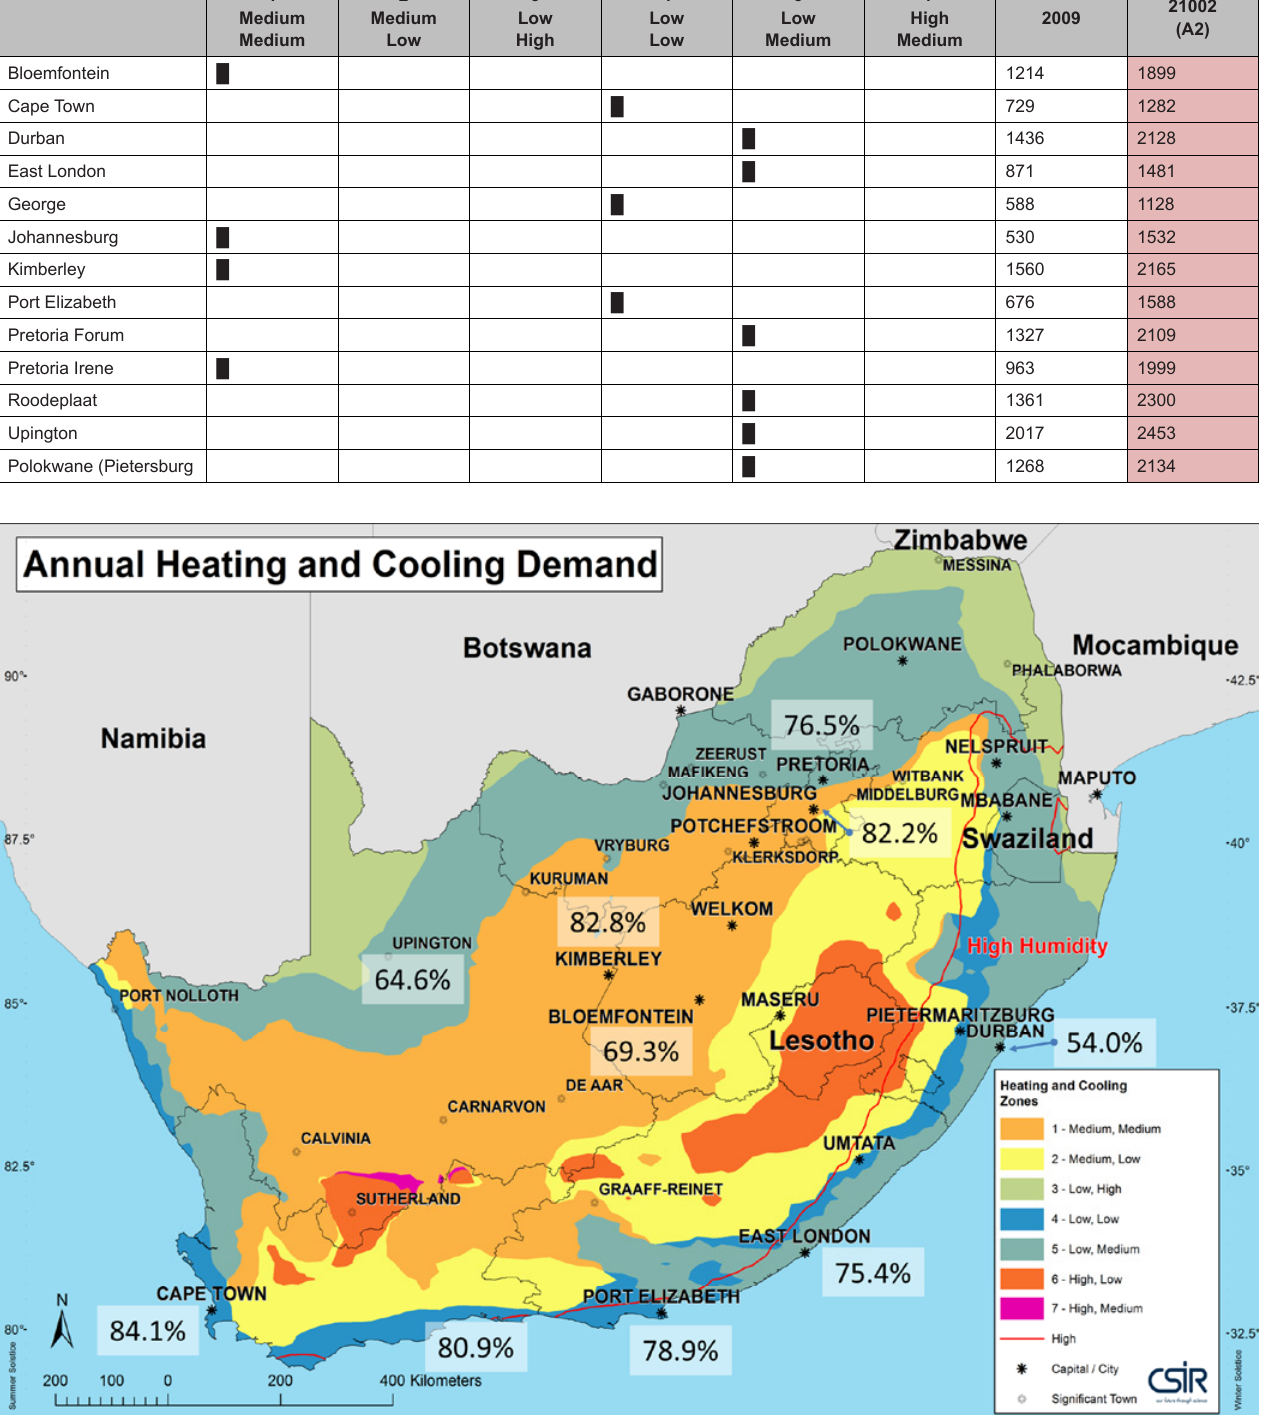
Figure 1: Combined heating and cooling low, medium and high (LMH) zone map with summer and winter humidity lines for South Africa (Conradie, Van Reenen & Bole, 2015: 101-117). The overlaid percentages indicate the bioclimatic calculated passive design potential of various cities in South